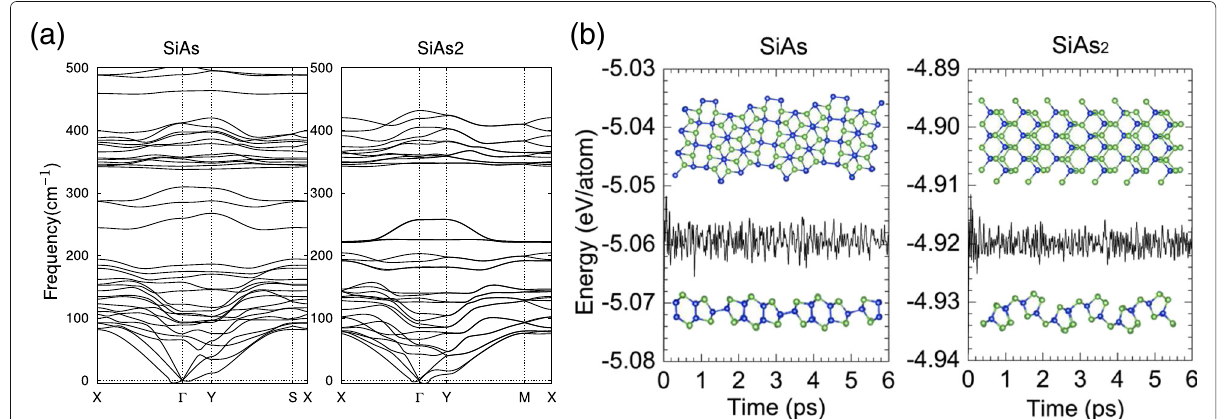
Fig. 2 Phonon dispersion curves and MD simulations of monolayers SiAs and SiAs 2 . a The phonon dispersion curves for monolayer SiAs and SiAs 2 . b Relationships of total energy and time during room-temperature MD simulations of SiAs and SiAs 2 . Selected snapshots of the monolayer structures at the end of 6 ps are also